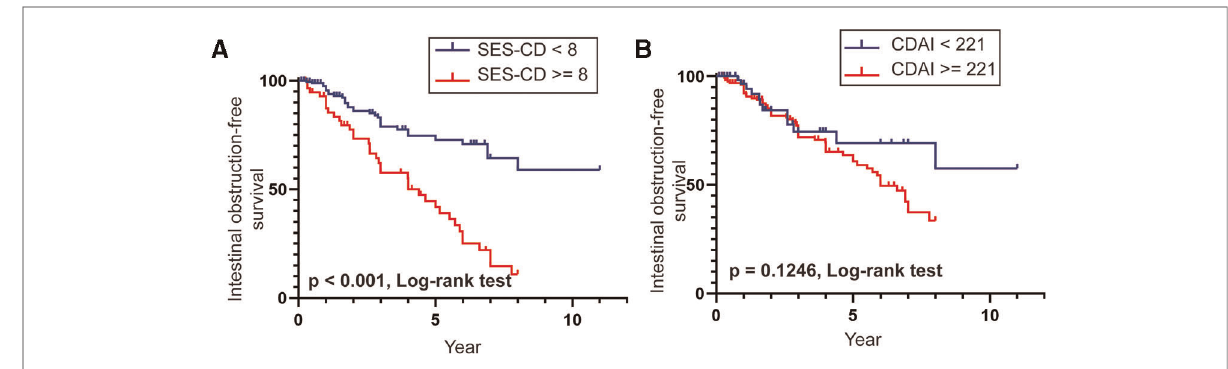
FIGURE 4 ( A,B ) Intestinal obstruction-free survival rates in patients with SES-CD ≥ 8 vs. SES-CD <8 and CDAI ≥ 221 vs. CDAI